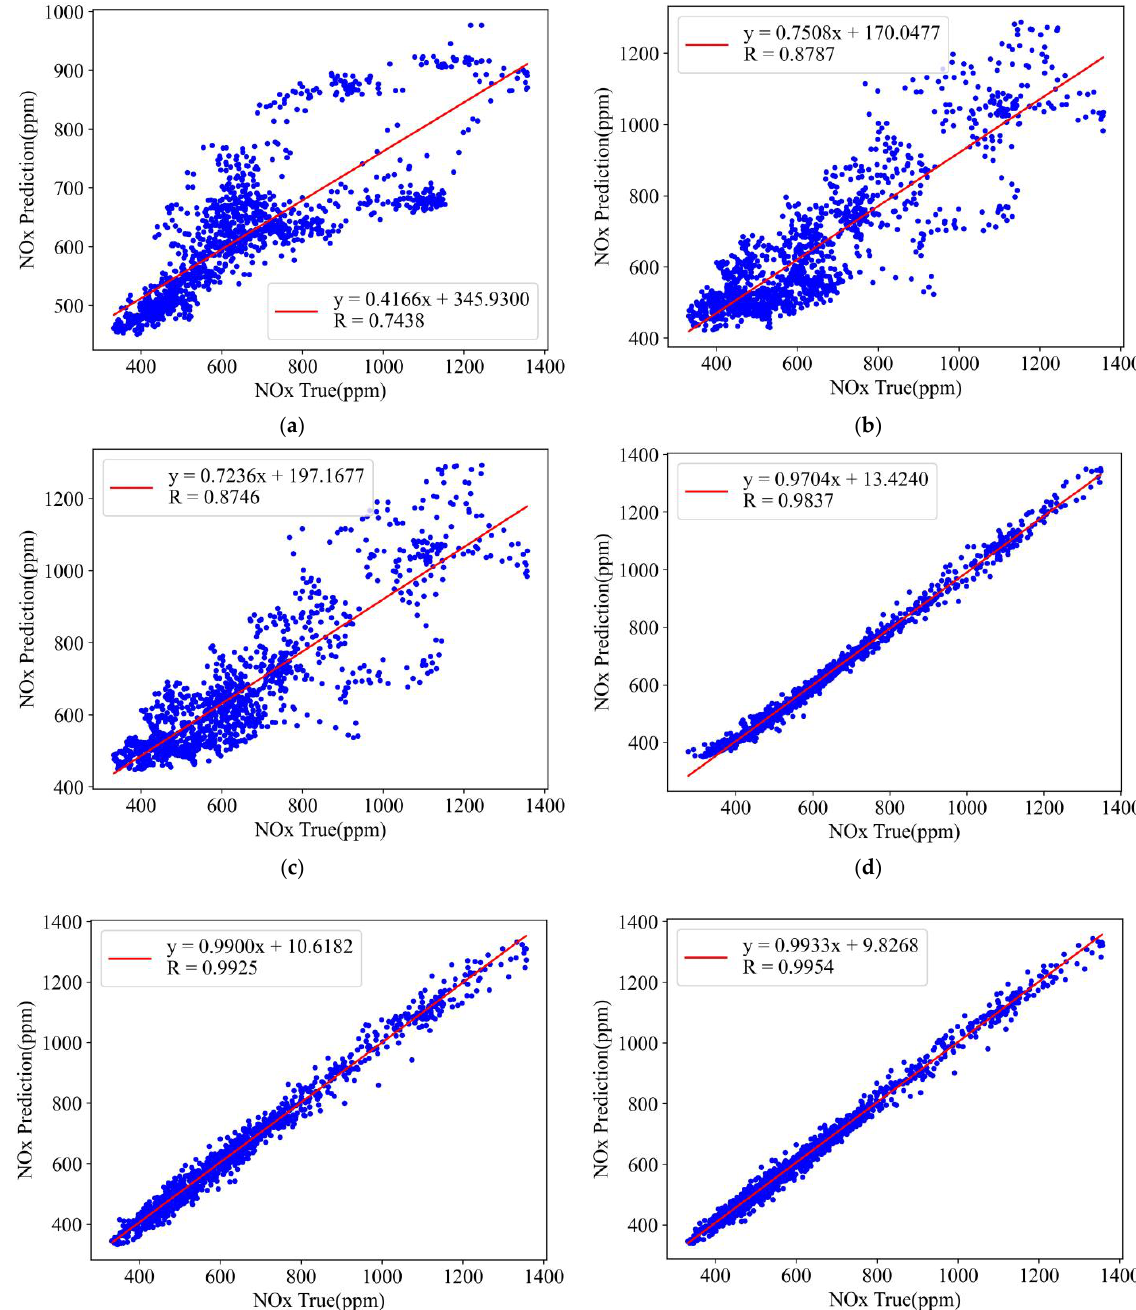
Figure 12. Linear regression and R 2 results of the single time step under the random condition. ( a ) Xgboost; ( b ) LSTM; ( c ) GRU; ( d ) Transformer; ( e ) StemGNN; ( f ) EGNN.